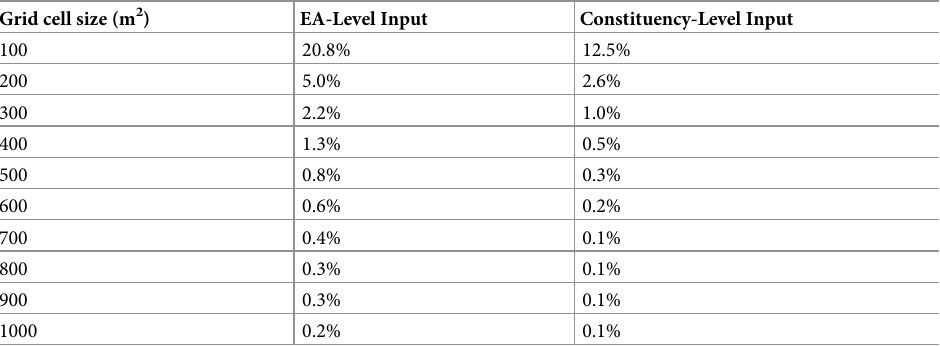
Table 6. Percent of the overall population that is misallocated to unsettled cells (no exclusion), by aggregation level of the input data and output grid cell